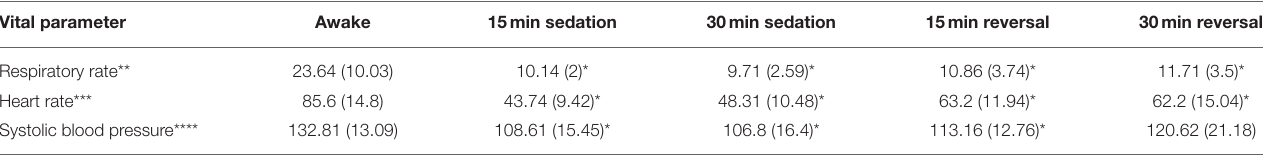
TABLE 1 | Vital parameters recorded at each timepoint during reflex testing.